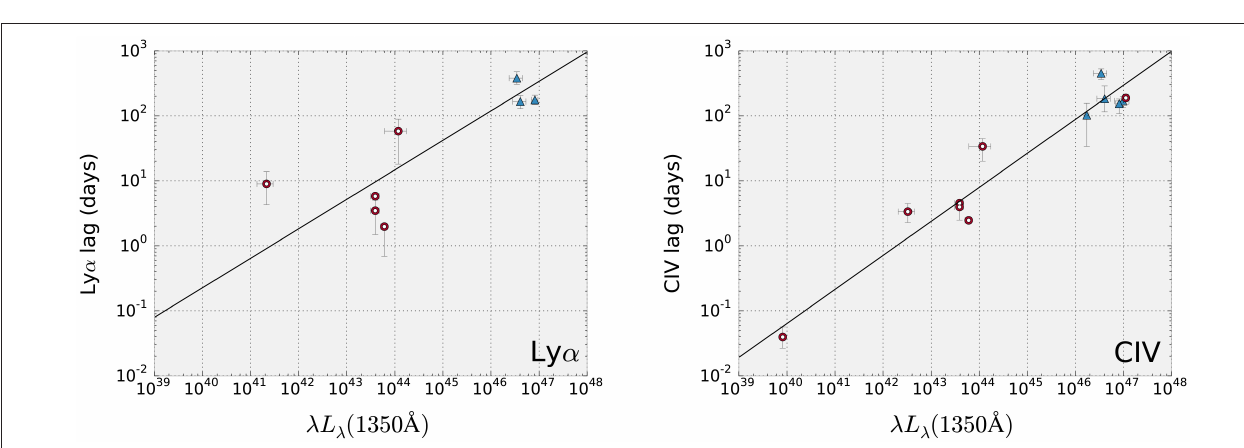
FIGURE 3 | Ly α (Left) and CIV (Right) radius–luminosity relations. Blue triangles correspond to results from our high- z , high-luminosity sample, while red circles are taken from the literature. These are NGC3783, NGC5548, NGC7469, F9, and 3C390.3 for the Ly α relation, and NGC4395, NGC5548, NGC3783, NGC7469, and 3C390.3 for the CIV relation ( Peterson et al., 2005, 2006; De Rosa et al., 2015; Lira et al., submitted). Taken from Lira et al. (submitted), ©